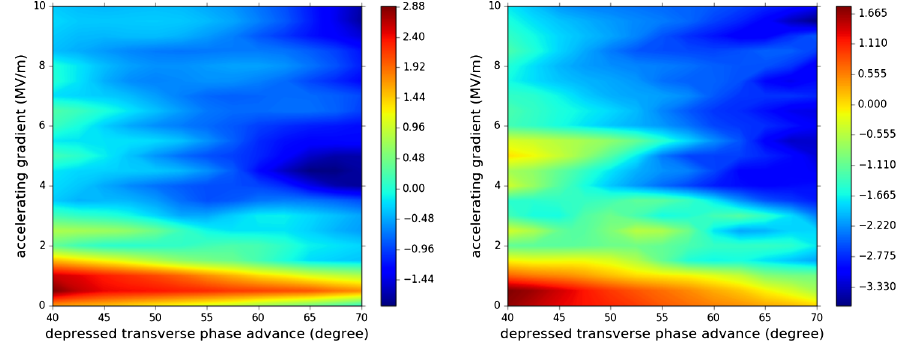
FIG. 12. The final log horizontal emittance growth (left) and longitudinal emittance growth (right) at the end of 100 lattice periods as a function of accelerating gradient and depressed transverse phase advance in the quadrupole-rf channel.